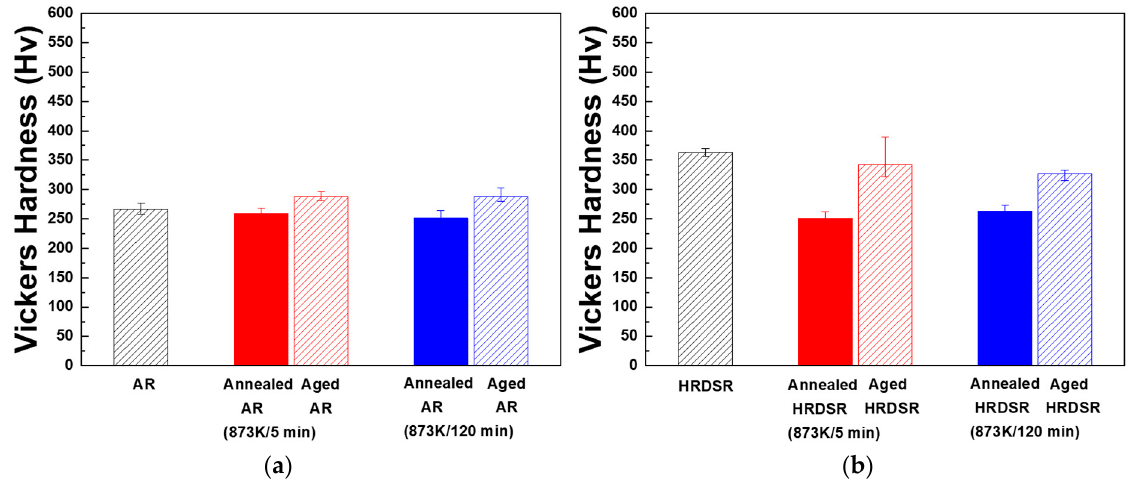
Figure 12. The Vickers hardness of the ( a ) AR and ( b ) HRDSR samples after annealing or annealing plus aging.